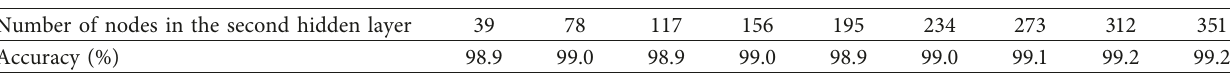
Table 5: Prediction accuracy of Chinese traditional musical instruments with different numbers of neuron nodes in two hidden layers. Number of nodes in the second hidden layer